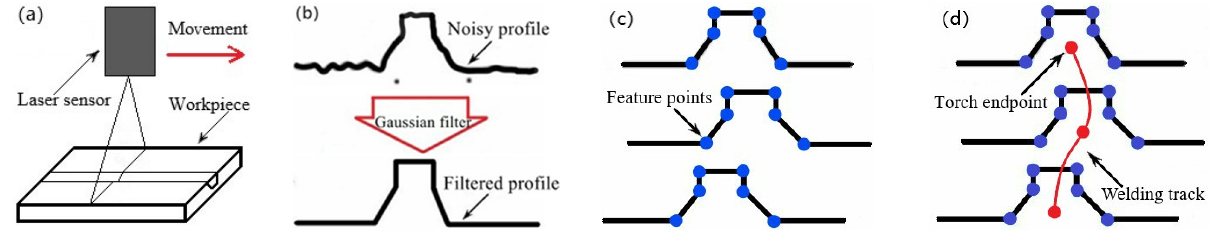
Figure 2. Flowchart of the four-step method for ( a ) scanning; ( b ) filtering; ( c ) feature points extracting; and ( d ) path planning.